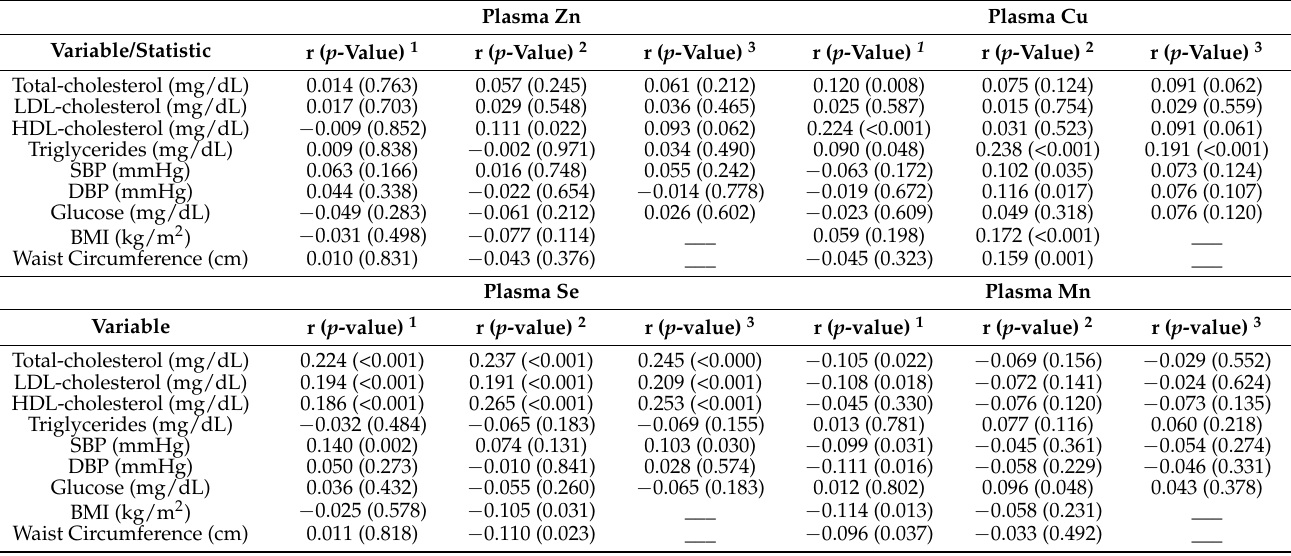
Table 2. Single association between plasma levels of trace elements and cardiovascular risk factors (as continuous).